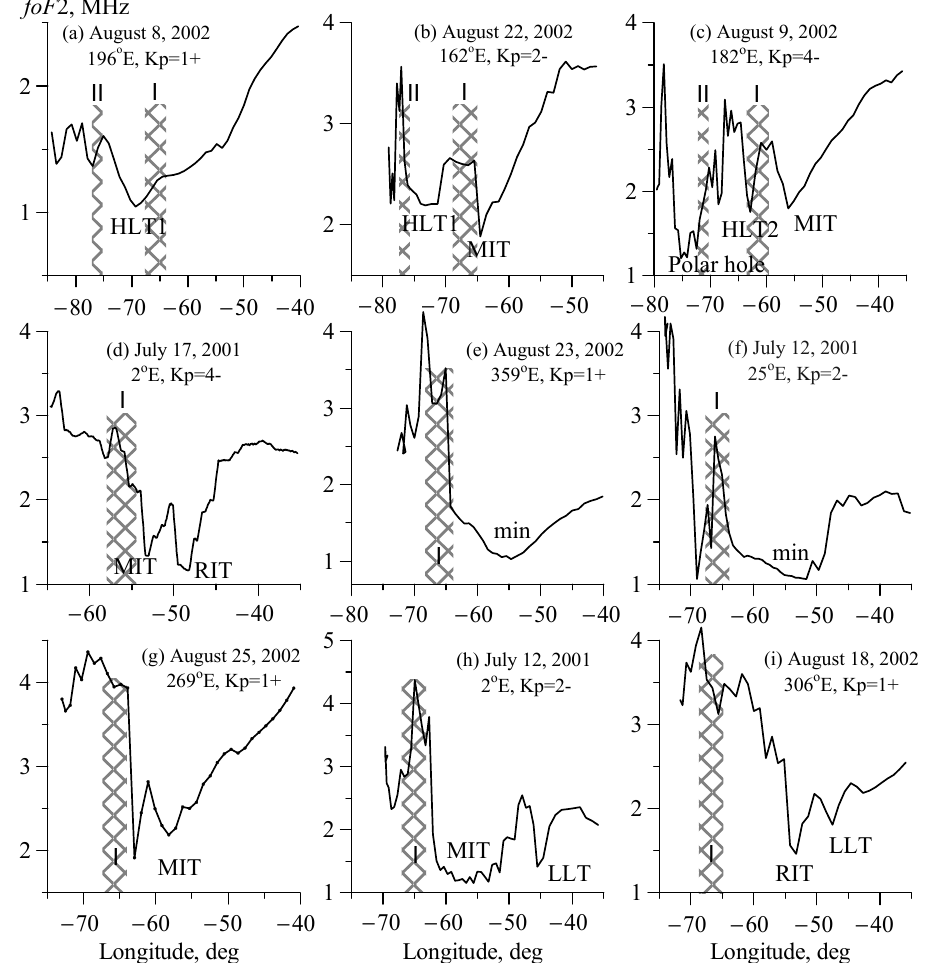
Figure 6. Characteristic examples of ionospheric troughs at different longitudes in the morning ionosphere.